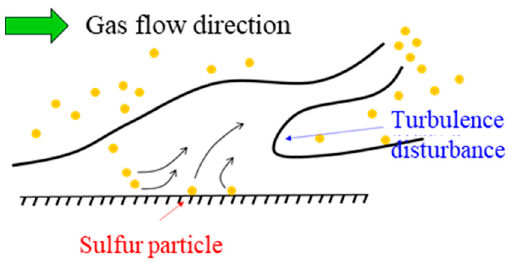
Figure 2. Sulfur release due to turbulence in a gas system.